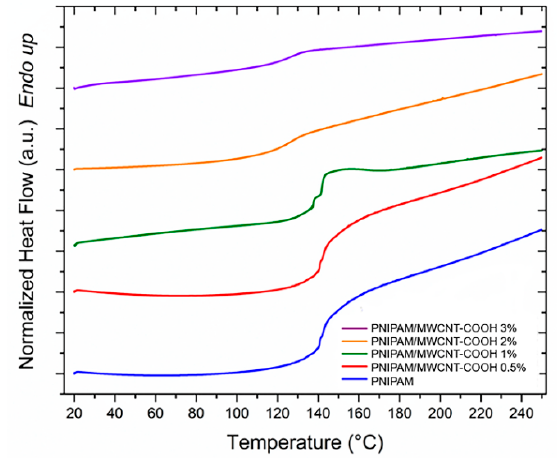
Figure 5. DSC curves (heating rate 5 °C/min) for T g evaluation of PNIPAM/MWCNT-COOH hydrogel samples at different concentrations of carbon nanotubes.